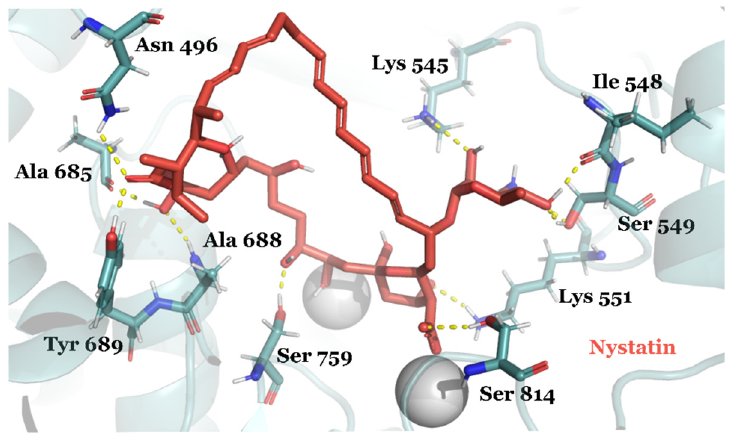
Figure 9. Nystatin-selected docking pose. RdRp’s residues are colored according to the atom type of the interacting amino acid residues (protein’s carbon, light teal; oxygen, red; nitrogen, blue). Dash lines represent the protein–ligand interactions: hydrogen bond interactions are colored in yellow; π - π interactions are colored in blue.